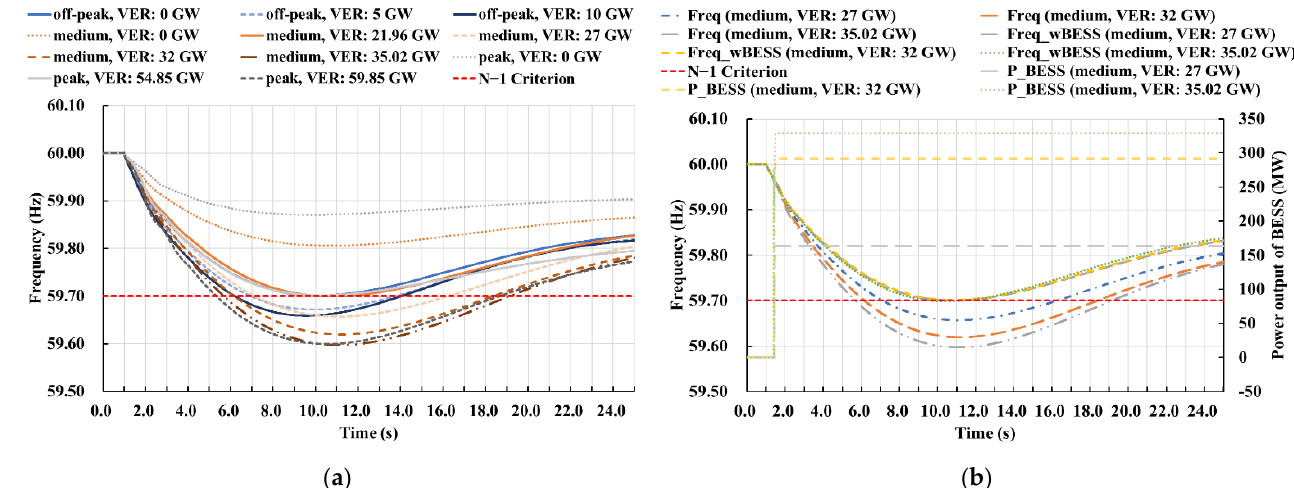
Figure 9. Analysis of the effect of BESS on increasing the penetration limit of VER: ( a ) Frequency response characteristics according to the penetration of VER under different load levels. ( b ) Analysis of the effect of BESS on increasing the penetration limit of VER under medium load.